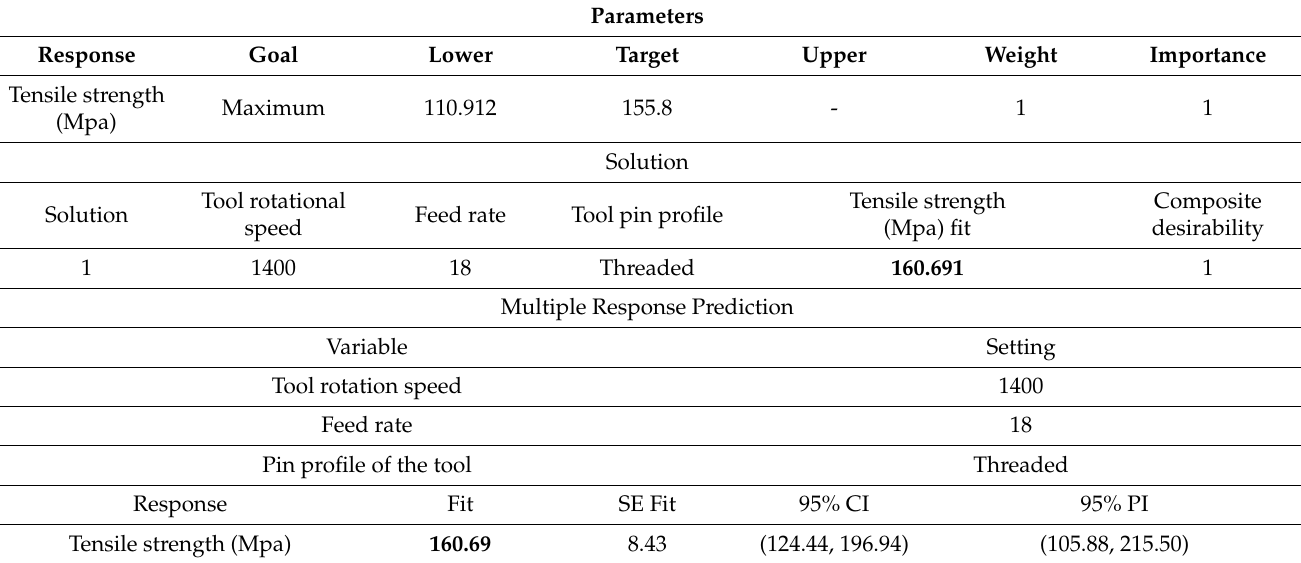
Table 7. Response optimization for tensile